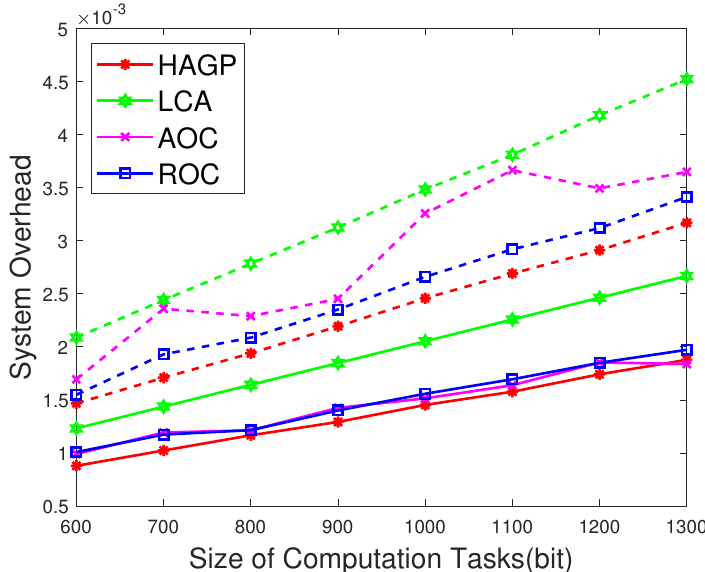
Figure 6. Overall system overhead vs. the size of computation tasks and λ e . The solid curves represent λ e = 0.8, while the dash curves represent λ e =